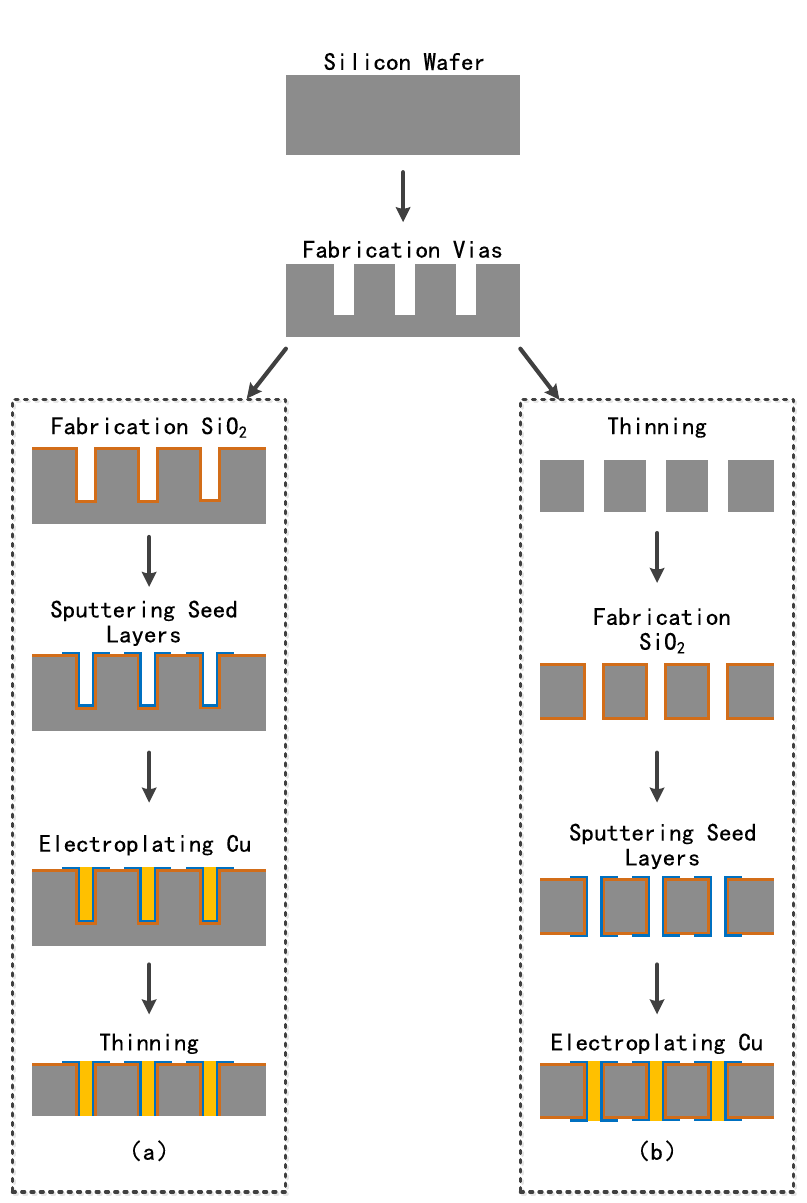
Figure 1. Illustration of through silicone via (TSV) fabrication process showing ( a ) blind vias and ( b ) through vias.